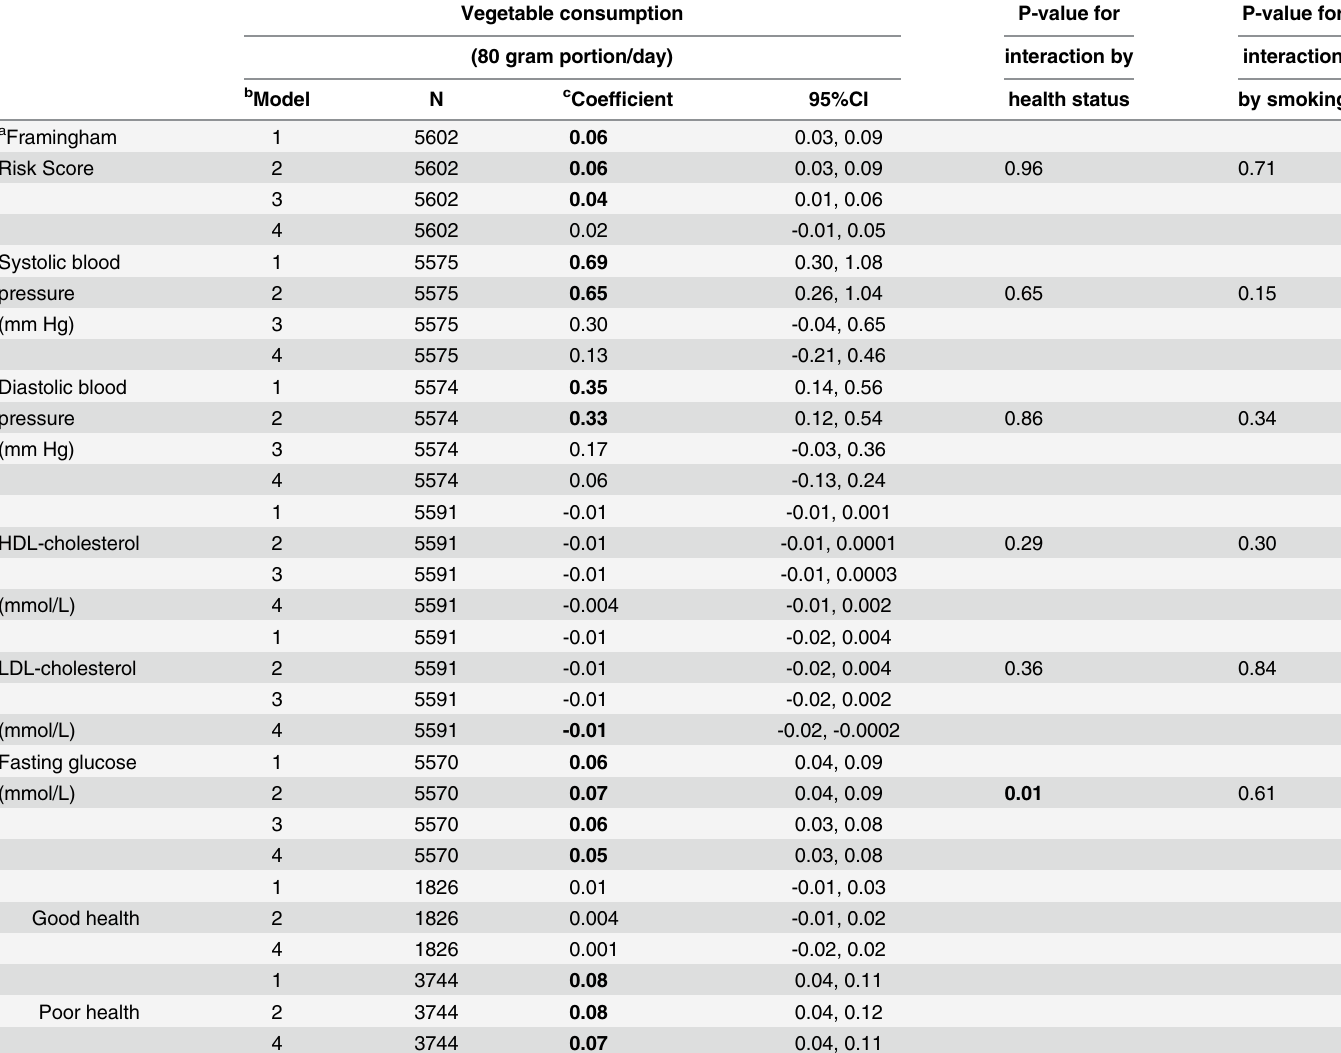
Table 5. Adjusted Associations of Vegetable Consumption with Framingham Risk Score and CVD Risk Factors after Multiple Imputation in Older Chinese Men in Phases 1 and 2 of the Guangzhou Biobank Cohort Study, 2003 –